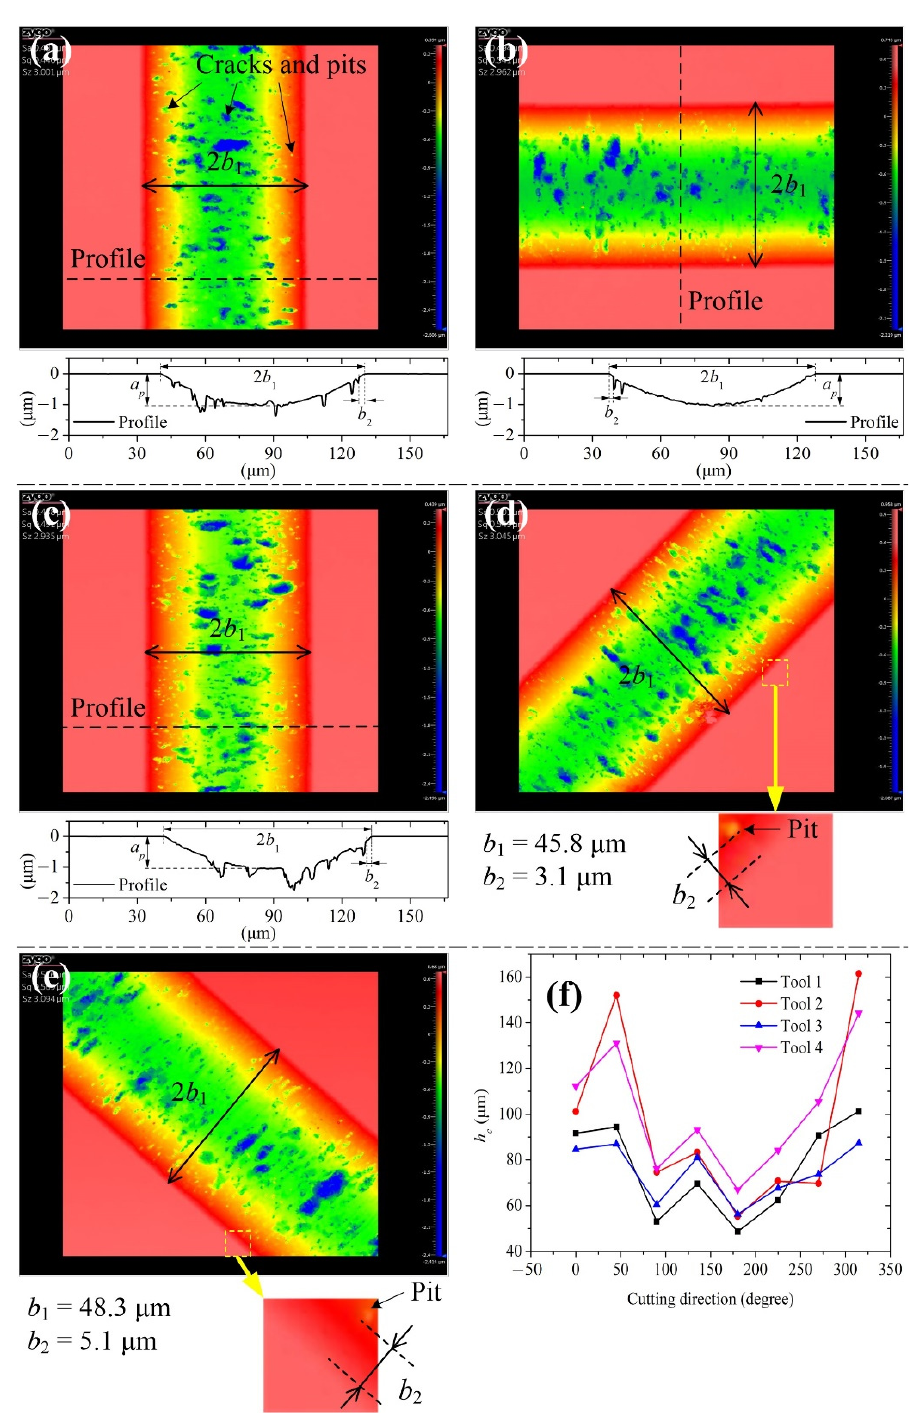
Figure 4. Morphology and profile of the groove under ( a ) 0°, ( b ) 90°, and ( c ) 180° cutting directions; morphology of the groove under ( d ) 45° and ( e ) 135° cutting directions; ( f ) different cutting directions induced by varying the critical UCT h c .